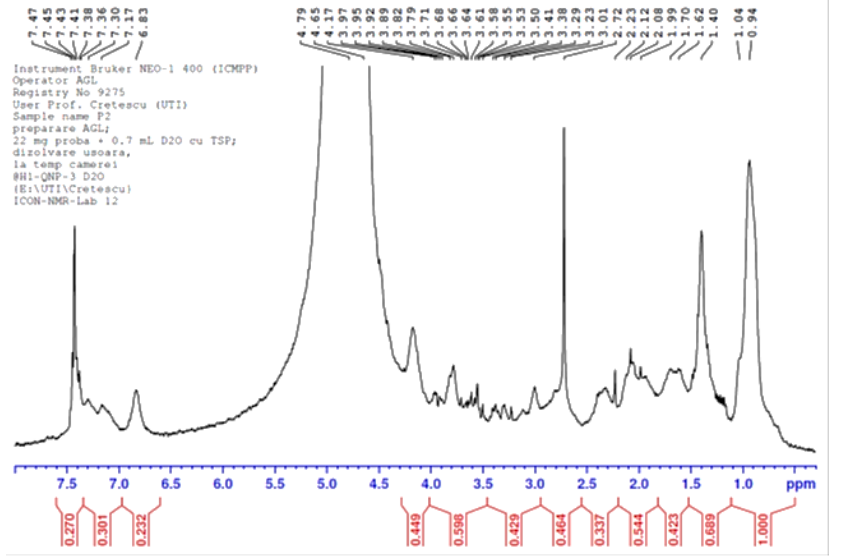
Figure 14. The enhanced-resolution 1 H-NMR spectra of the chitin-based oligosaccharides separated from the deproteinization solution.